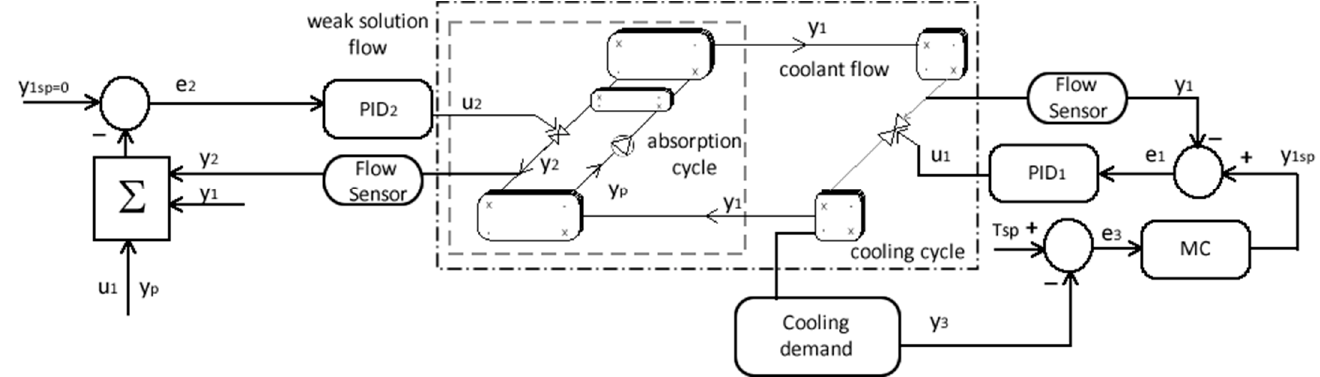
Figure 4. Block diagram of a cascade PID feedback loop applied on the SACS.